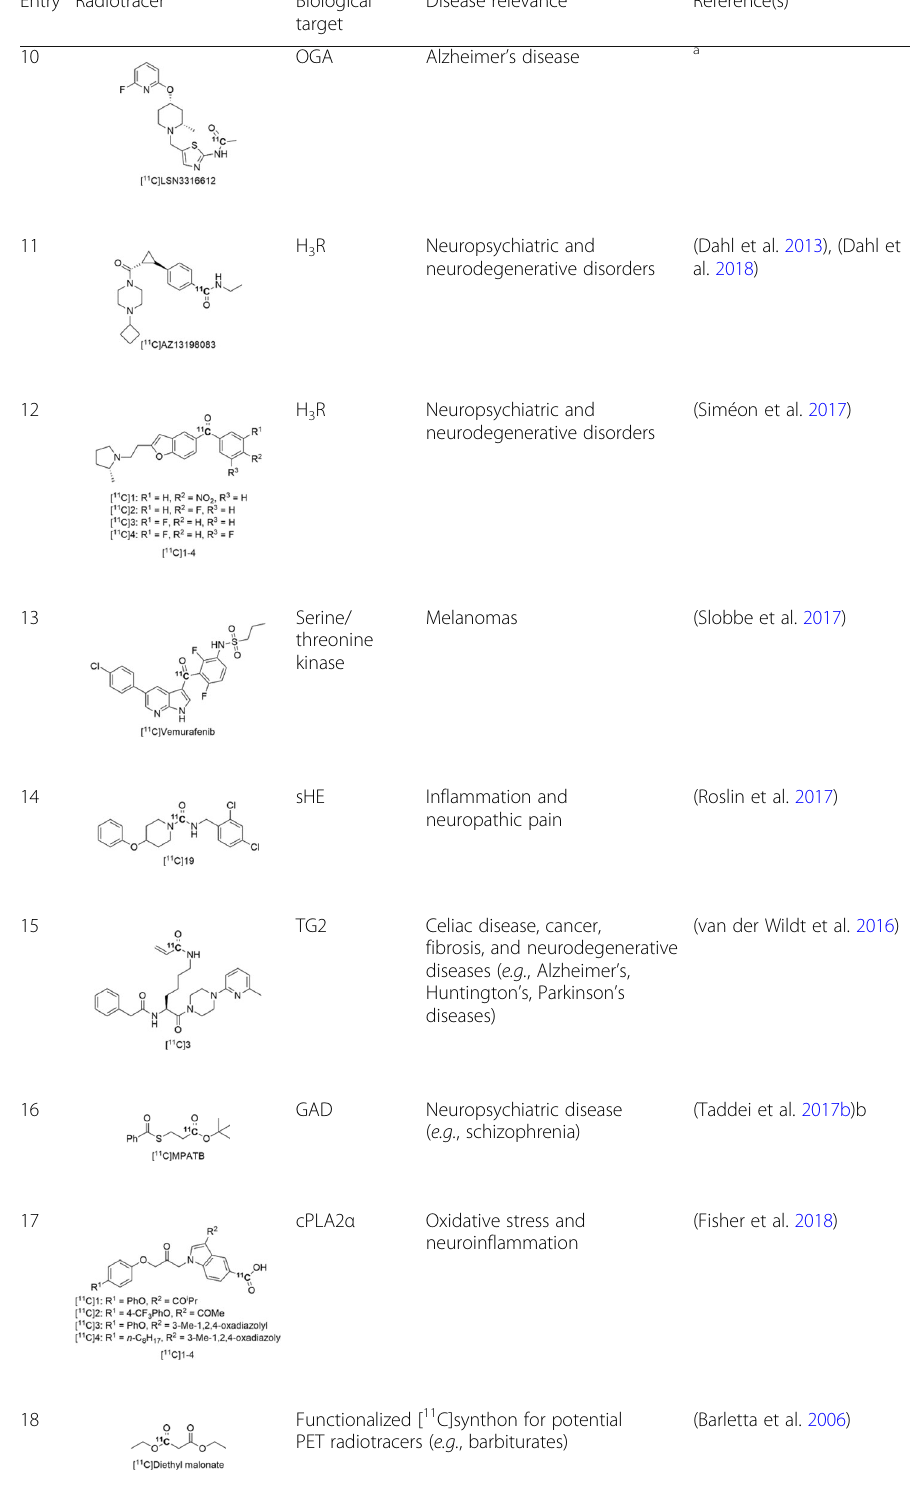
Table 1 Radiotracers radiolabeled using [ 11 C]carbon monoxide, the corresponding biological target, and disease relevance